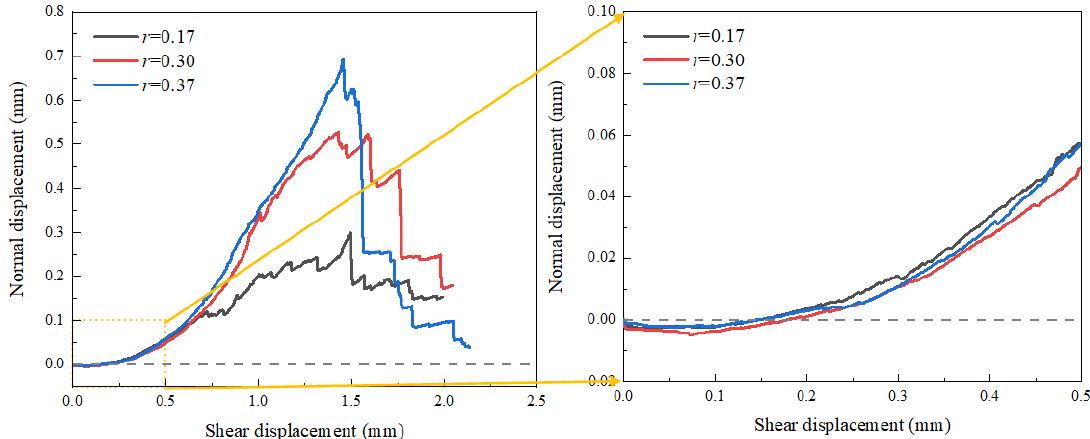
When the regular dentate joints are put through a shear test, it is noticeable that the normal deformation of the joints changes as the shear displacement increases. This is pri- marily because the joints along the dentate slope upward are subject to both normal stress and shear stress simultaneously. The shear dilatancy curve of the joints can be calculated by using the shear displacement of the joints as the horizontal coordinate and the normal displacement as the vertical coordinate. Figure 5 depicts the shear dilatancy curve for the same normal stress (2 MPa) and various roughness specimens in accordance with the test results. Figure 5 illustrates the evident discrepancies between the shear dilatancy proper- ties of various roughness joints and the shear dilatancy curves. The joint sample is at the volume compression stage during the early stage of applying shear stress, and the shear dilatancy curve grows downward with a non-linear slope that eventually diminishes (Fig- ure 5). The shear dilatancy curve shifts upward noticeably when the shear displacement is 0.1 mm, and the maximum shear dilatancy becomes more significant with an increase in joint roughness, with the maximum shear dilatancy of the joints with roughness of 0.17 being significantly smaller than that of the joints ( r = 0.30, 0.37). After reaching the maxi- mum shear shrinkage, the specimen volume begins to increase uniformly, and the joints with larger roughness start to climb and expand earlier. The shear dilatancy curve is wavy after attaining the maximum shear dilatancy, and the normal displacement of the joints with roughness of 0.17 and 0.30 fluctuates slightly close to the peak. After the joints are sheared along the dentate, sliding friction along the shearing surface is the principal cause of it. The normal displacement of the joints with a roughness of 0.37 declines fast with continuous loading of shear displacement, and the normal deformation of the joints once more moves into the compression stage as the dentate is sheared and crushed under the influence of normal stress and shear force. Figure 4. Relationship between shear strength and roughness of the dentate joints.